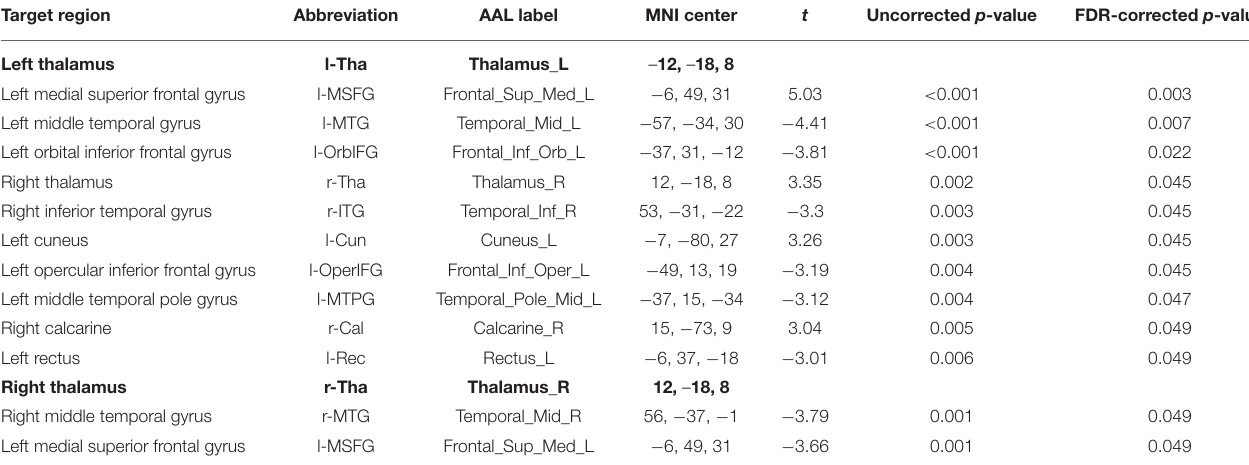
TABLE 2 | ROI-to-ROI functional connectivity statistics: comparisons between RW and ASD scans (ASD > RW, paired t -test, n = 28). Target region